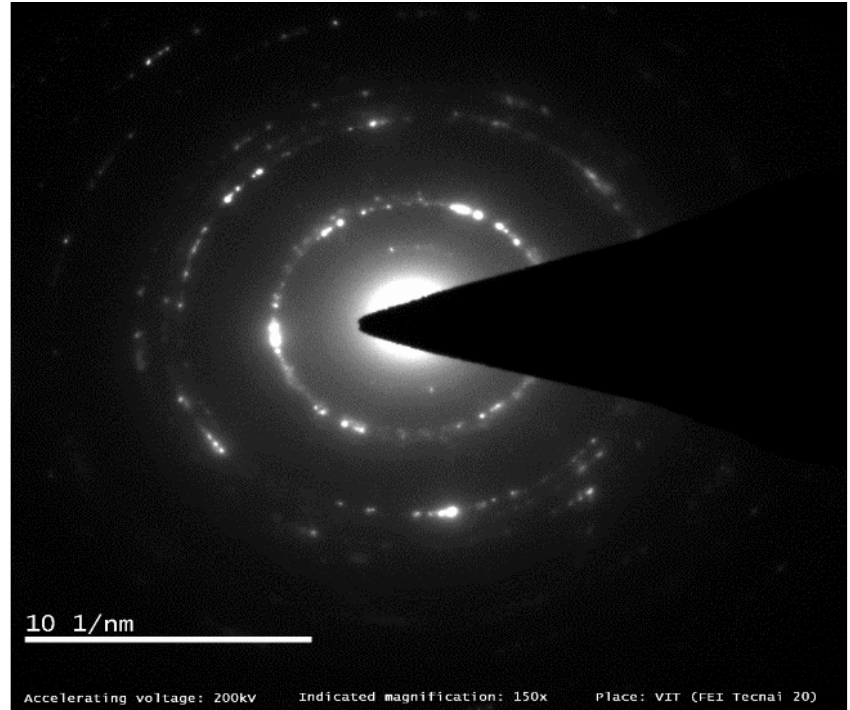
Figure 7. HR-TEM. Electron Diffraction pattern of graphene obtained from HR-TEM.